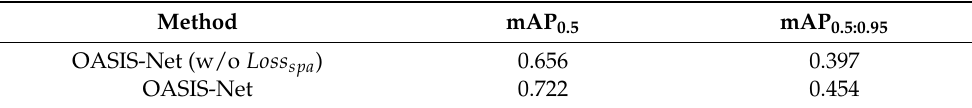
Table 8. Ablation study results of OASIS-Net for spalling